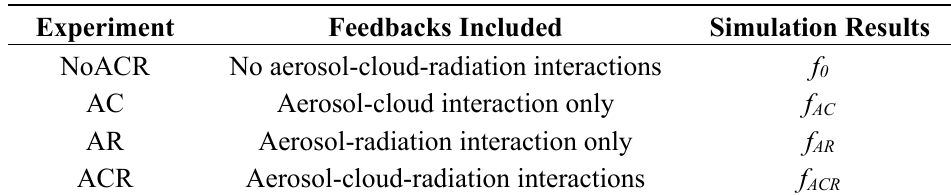
Table 1. Experiment